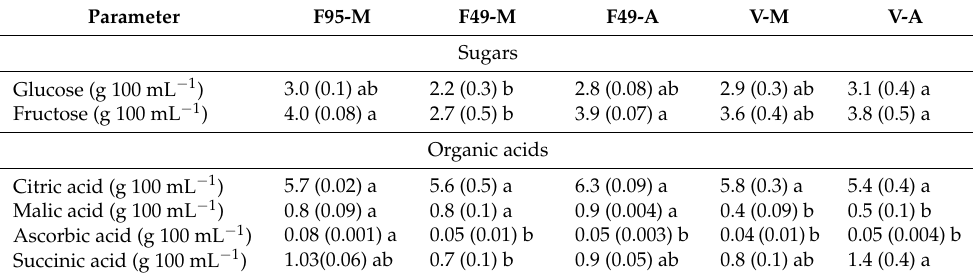
Table 5. Variations of sugars (glucose and fructose) and organic acids (citric acid, malic acid, ascorbic acid and succinic acid) of lemons (“Fino 95”, “Fino 49” and “Verna”) obtained in different rootstocks ( C. macrophylla and C. aurantium ). The values represented are the mean with their standard deviation in parentheses.